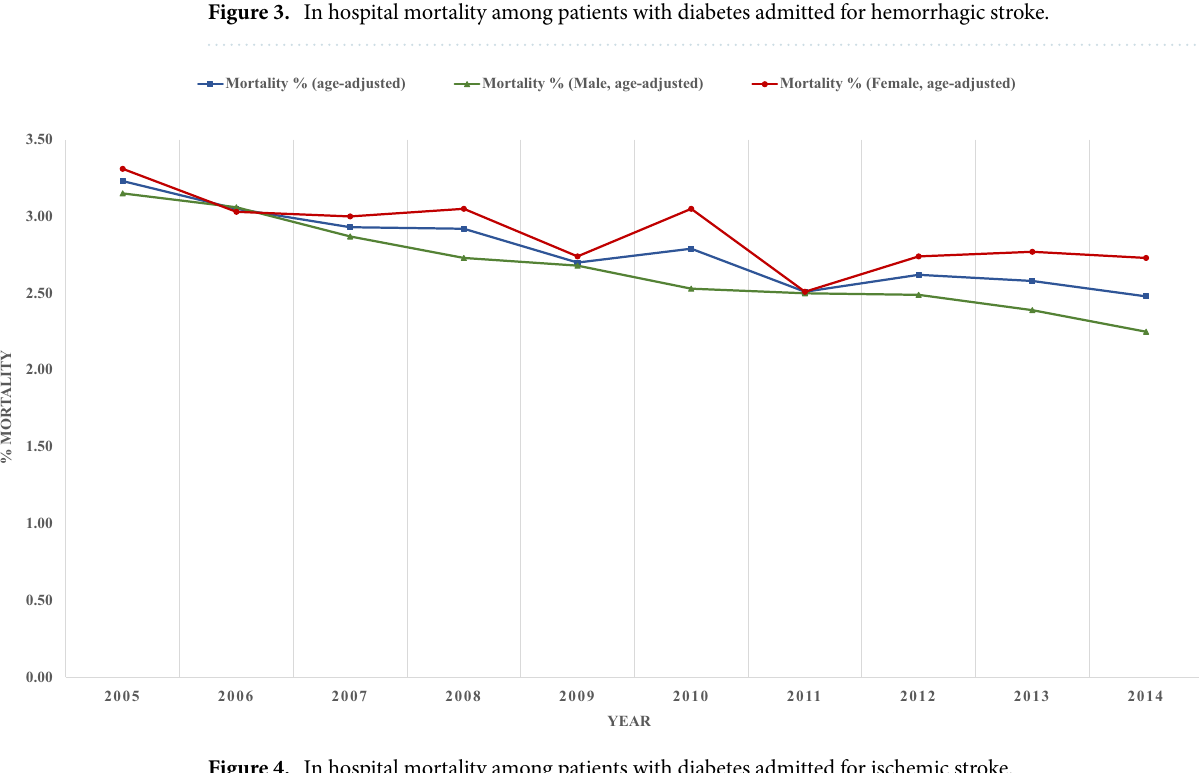
Figure 4. In hospital mortality among patients with diabetes admitted for ischemic